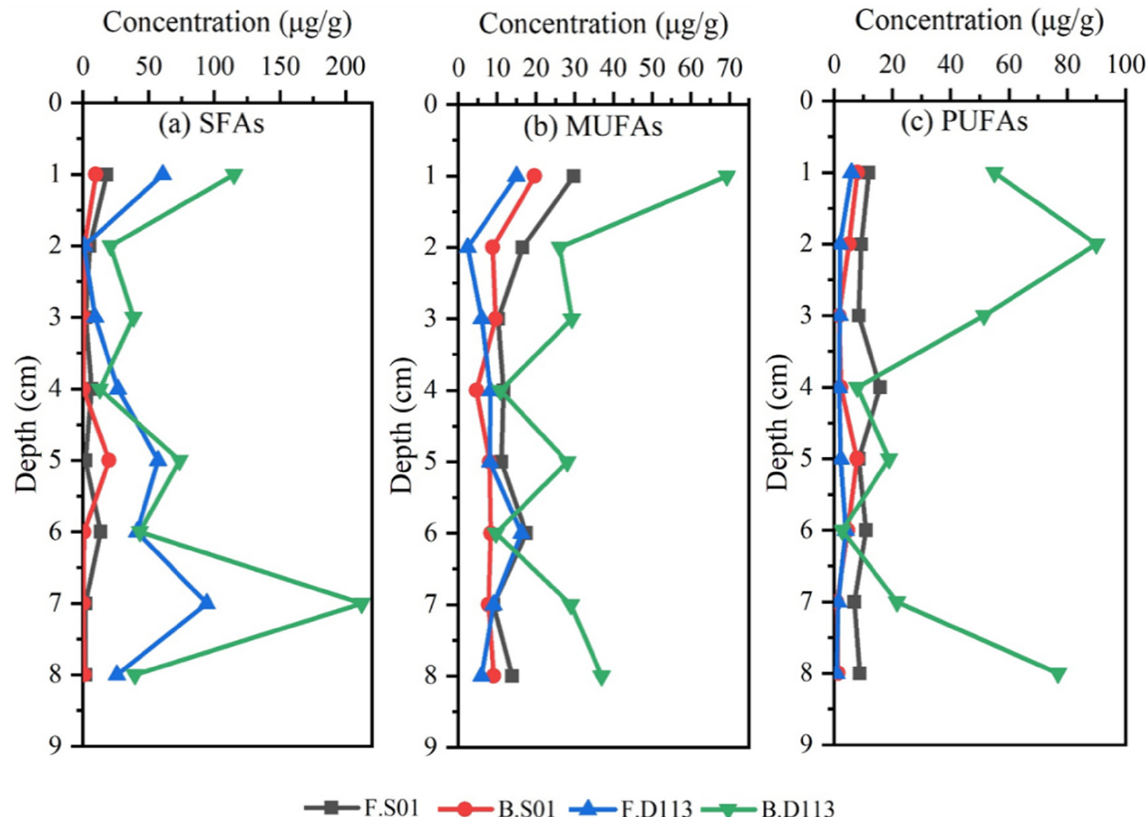
Figure 5. Comparison of concentrations of FAs in the two sediment samples. Where panel ( a ) rep- resents the concentrations of SFAs, panel ( b ) represents the MUFAs, and panel ( c ) represents the PUFAs in free and bound forms of the two stations. F.S01 and F.D113 represent free FAs and B.S01 and B.D113 represent bound FAs in the two sediment samples.